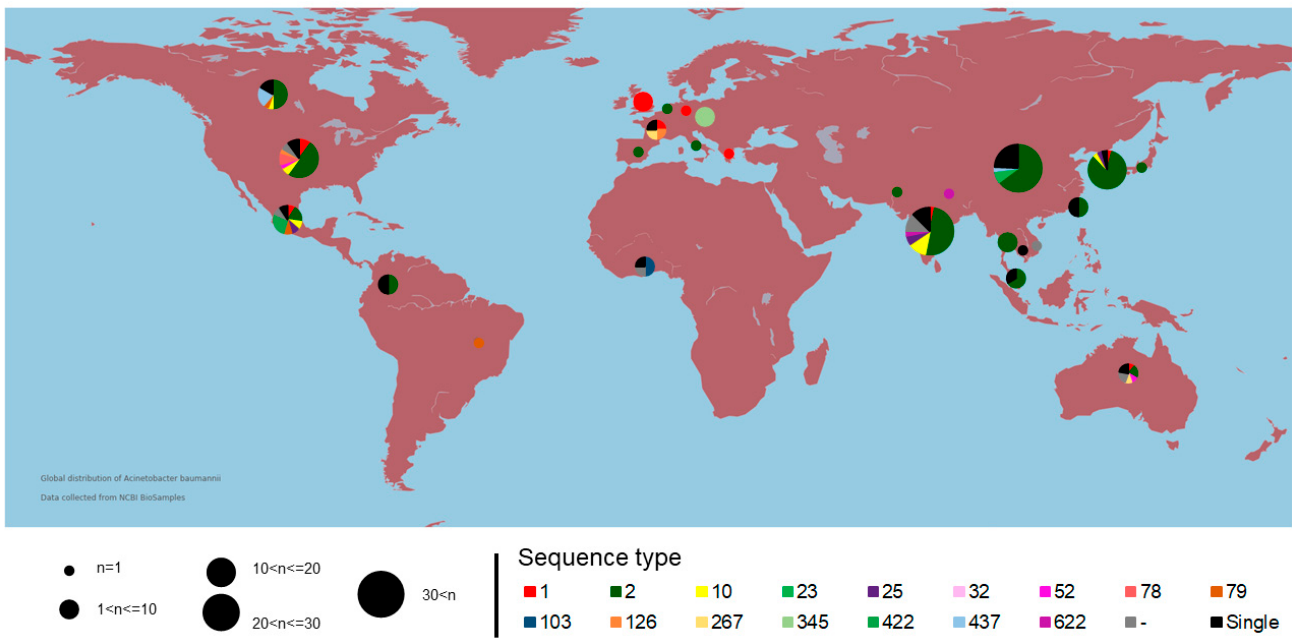
Figure 1. Graphical representation of the global distribution of isolation sites of different strains of Acinetobacter baumannii in a grouped way. The colors represent the sequence types of the strains in this study. The size of the circle indicates the number of isolated strains.